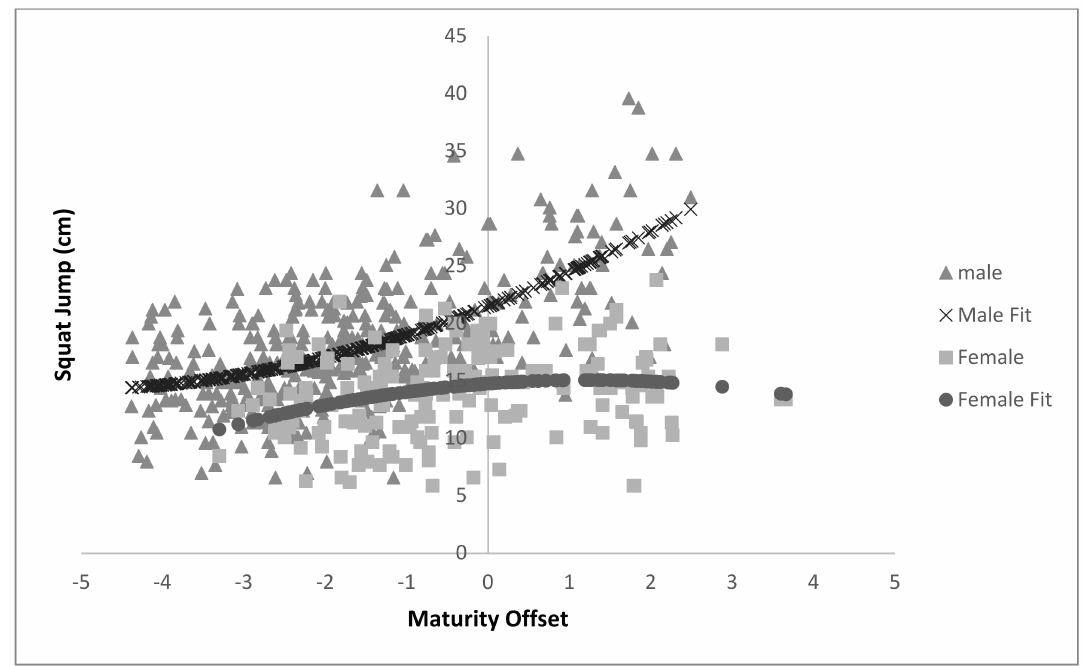
Figure 3. The quadratic associations between squat jump (cm) and maturity offset (yrs) for boys and girls.